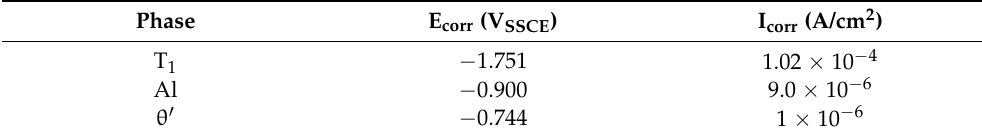
Table 4. Corrosion potential and current density of precipitates